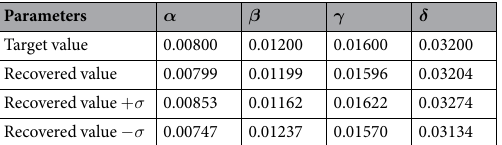
Table 1. Parameter values for simulation of historical date with range of parameter